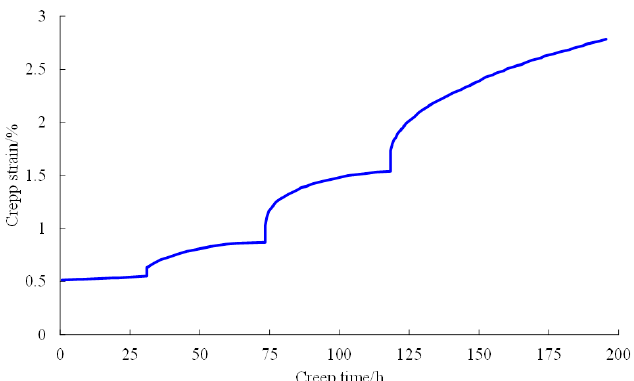
Figure 3. Creep curve of rock salt from Pingdingshan salt mine. The test contains four stress condi